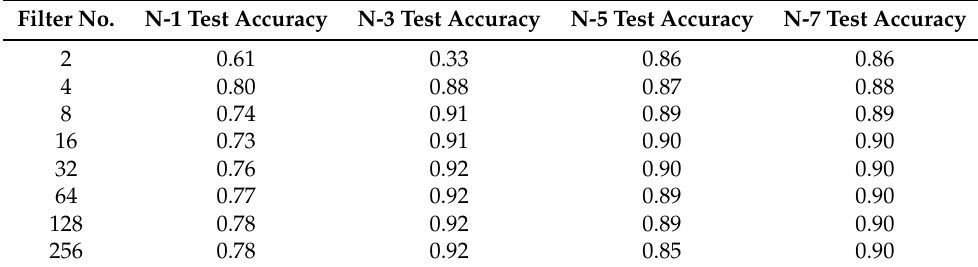
Table 2. Accuracy Rate of model networks using various number of learnable filters on N-3, N-5 and N-7 dastaset. Filter No.